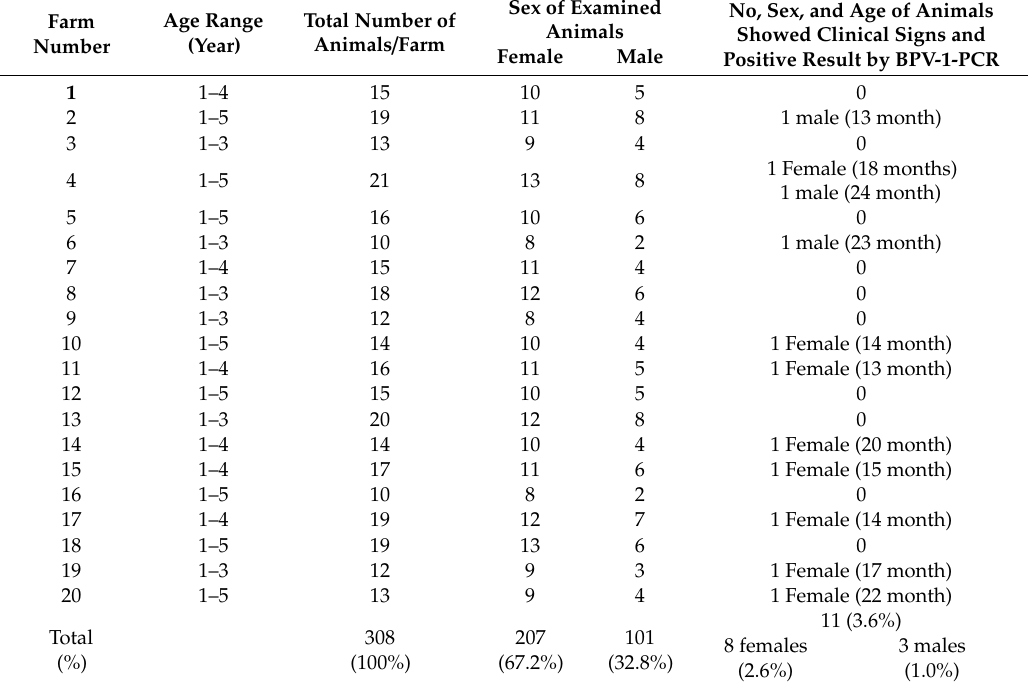
Table 1. Details of examined animals ( n = 308) that showed clinical signs of bovine papillomatosis